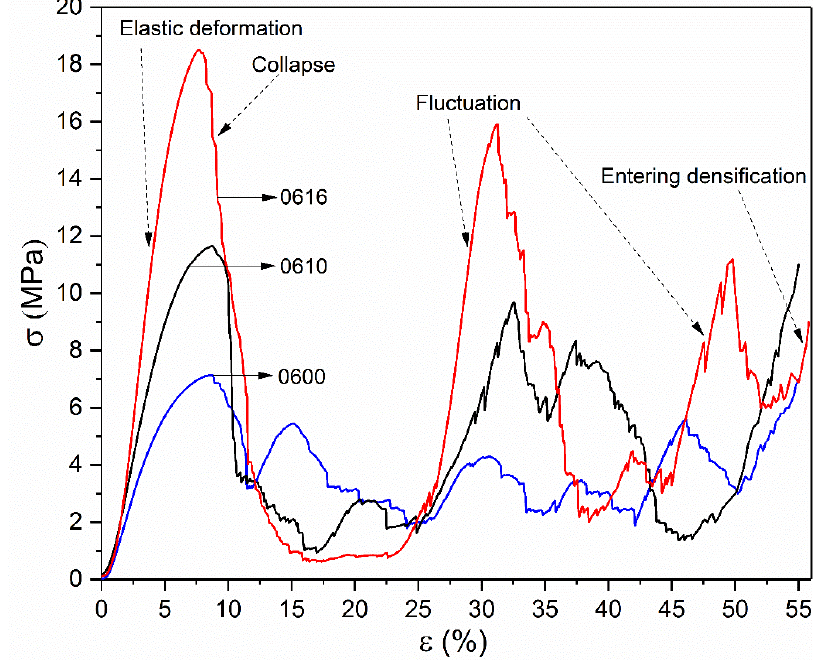
Figure 9. Compressive stress–strain curve of 0600, 0610 and 0616 samples.